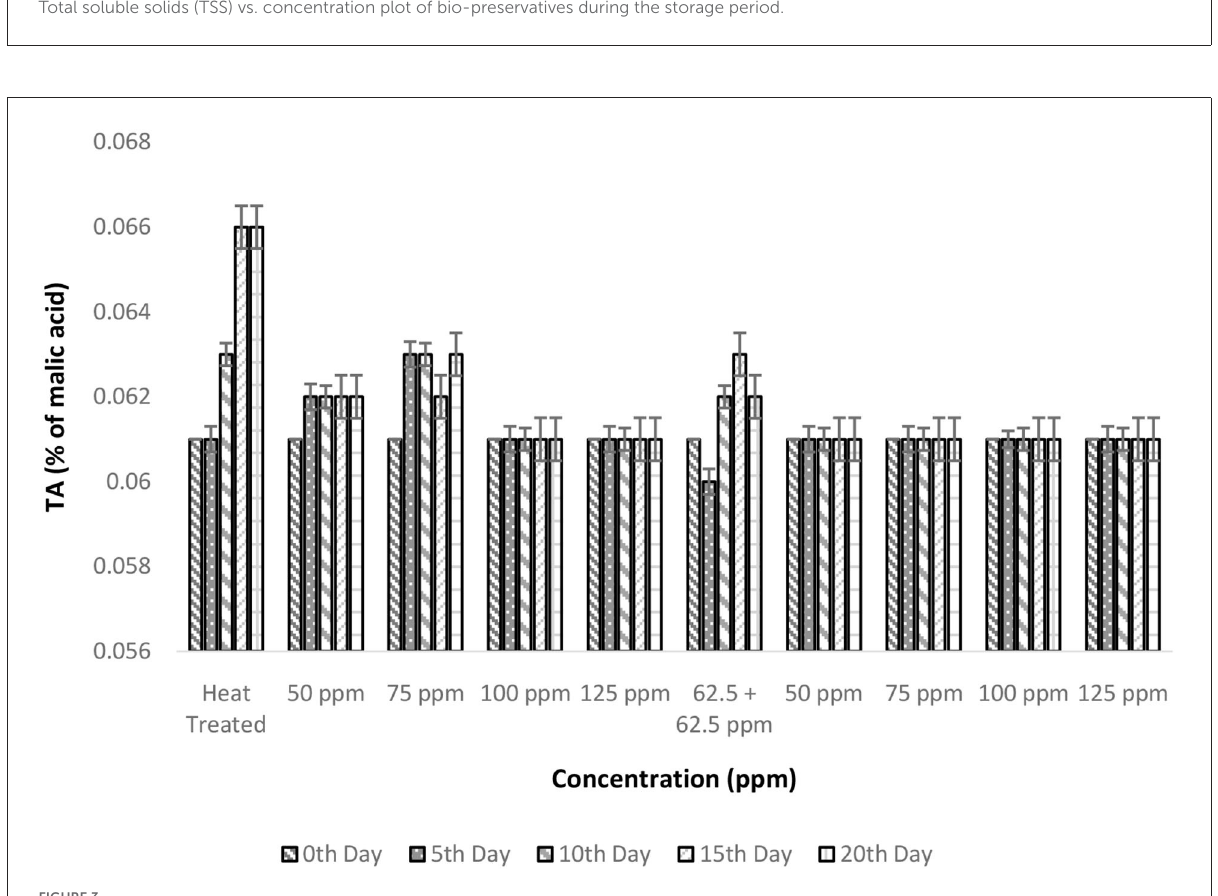
FIGURE3 Titratable acidity vs. concentration plot of bio-preservatives during the storage